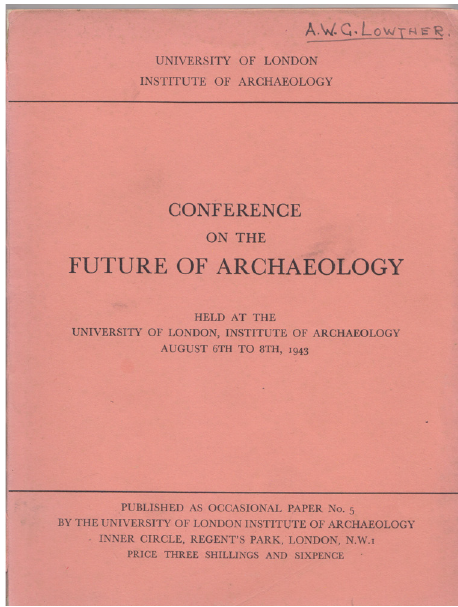
Fig. 2: The proceedings of the ‘Conference on the Future of Archaeology’